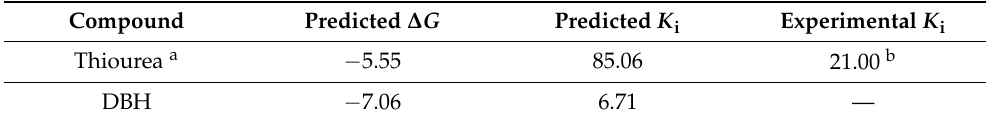
Table 2. Predicted free energies of binding ( Δ G , kcal/mol) and inhibition constant ( K i , μ M) for the urease receptor.